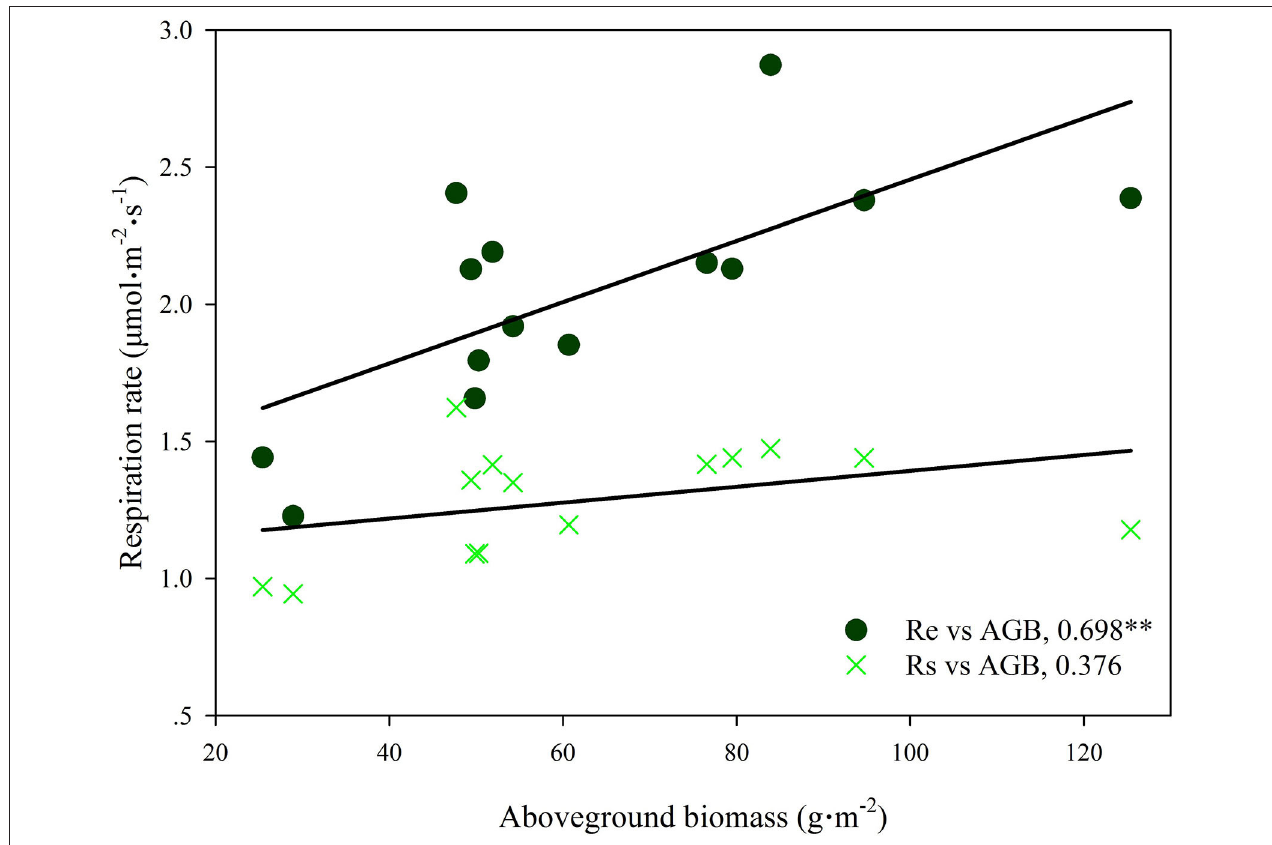
FIGURE 6 | Relationships between AGB and Re and Rs. Each point is the average value through time. * p < 0.05 and ** p < 0.01.